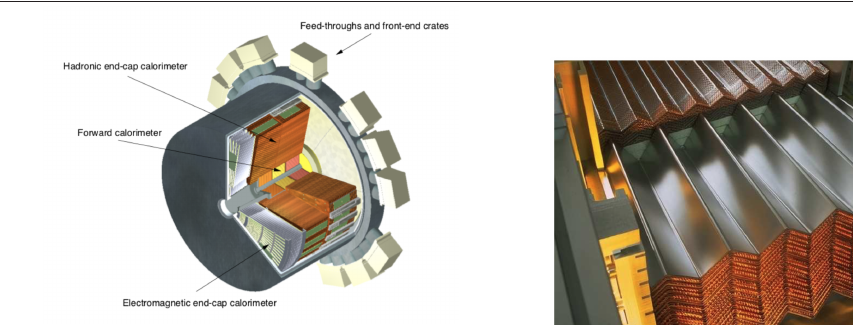
Figure 3: Picture of an electromagnetic end-cap module showing the accordion structure of the ATLAS EM